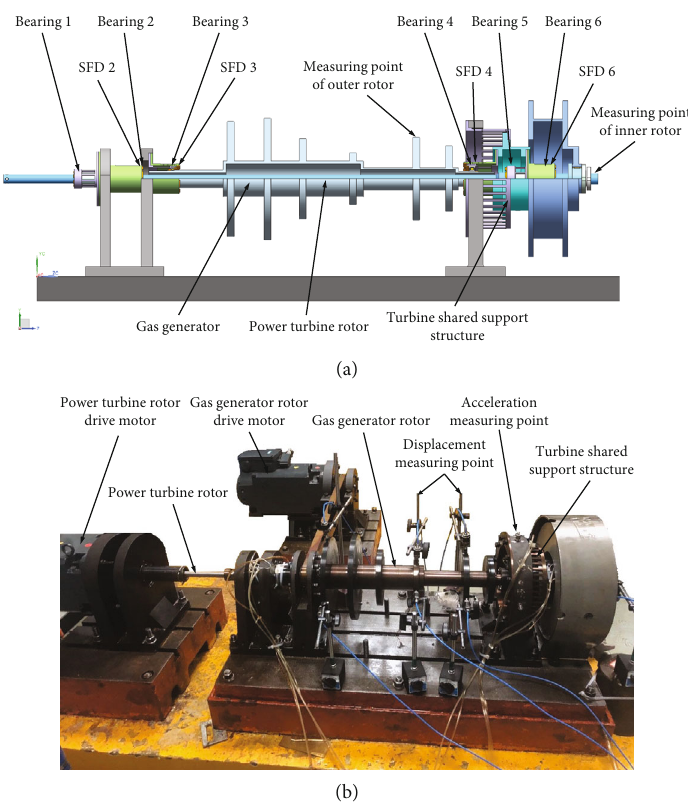
Figure 2: Rotor-bearing test system: (a) schematic; (b) photograph.